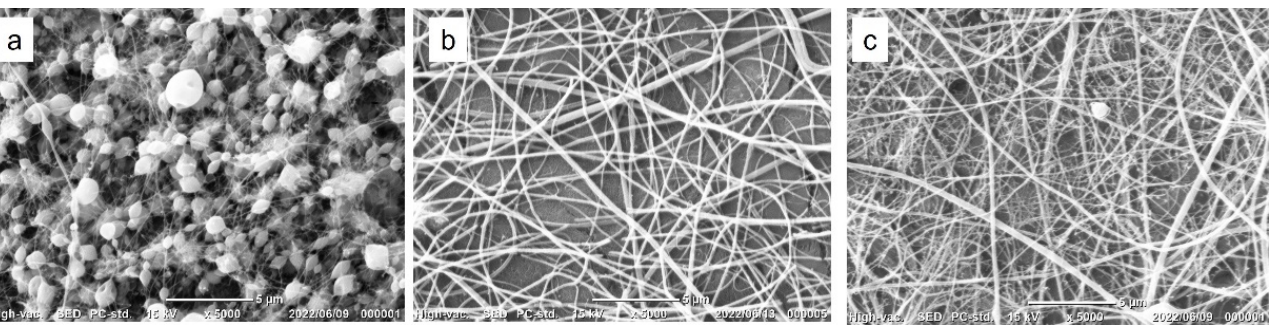
Figure 2. SEM images of Gelatin-Ph nanofibers obtained from 12 w / v % Gelatin-Ph solutions con- taining ( a ) 1 w / v %, ( b ) 2 w / v %, and ( c ) 4 w / v % PEO. ing ( a ) 1 w / v %, ( b ) 2 w / v %, and ( c ) 4 w / v %